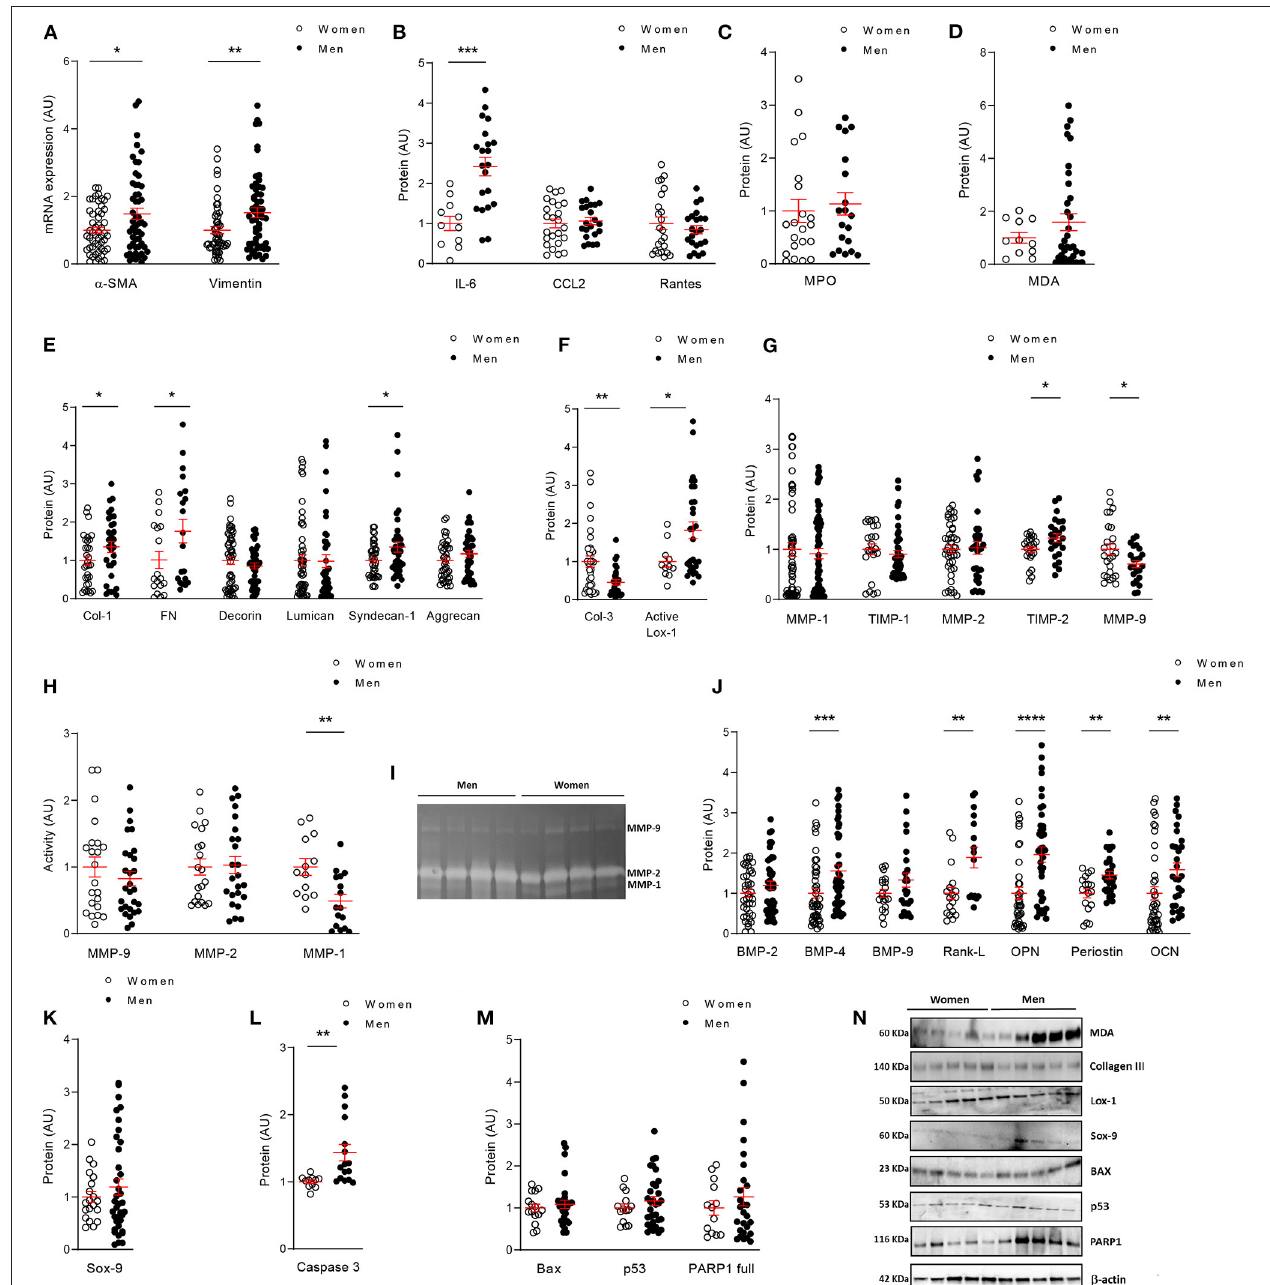
FIGURE 4 | In vitro comparative analysis between human VICs from women and men. mRNA levels of VICs activation markers (A) in women and men VICs. Protein expressions of inflammatory markers by ELISA (B) , oxidative stress markers by ELISA (C) or western blot (D) ; and fibrosis markers analyzed by ELISA (E) or western blot (F) in VICs from male and female human AVs. Comparison of ECM remodeling protein levels (G) and activity (H) in women and men VICs. Representative zymograme of MMP-9, − 2 and − 1 (I) . Levels of calcification markers measured by ELISA (J) or western blot (K) ; and apoptosis markers studied by ELISA (L) or western blot (M) in human VICs. Representative western blots for oxidative stress, fibrosis, calcification and apoptotic markers (N) . ECM, extracellular matrix; α -SMA, alpha smooth muscle actin; IL, interleukin; CCL2, C-C Motif Chemokine Ligand 2; MPO, myeloperoxidase; MDA, malondialdehyde; Col, collagen; FN, fibronectin; Lox-1, lysyl-oxidase-1; MMP, matrix metalloproteinase; TIMP, metalloproteinase inhibitor; BMP, bone morphogenetic protein; Rank-L, Receptor activator of NF-kappa B ligand; OPN, osteopontin; OCN, osteocalcin; Sox-9, SRY (sex-determining region Y)-box 9; BAX, BCL-2-associated protein; PARP1, Poly [ADP-ribose] polymerase 1. Gene expression data were normalized to HPRT, β -actin and GADPH. Dot plots represent mean and standard error of the mean (SEM) of each group of subjects (women n = 12 and men n = 24, VICs from each patient have 3–8 replicates) in arbitrary units (AU). All data were normalized to women. Protein markers were measured by ELISA or western blot (normalized to stain free protein and β -actin). * p < 0.05 vs. Women; * p < 0.05, ** p < 0.01, *** p < 0.001, **** p < 0.0001.